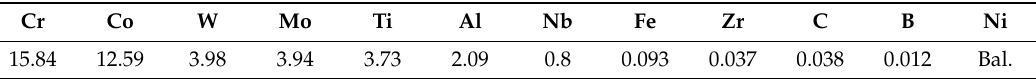
Table 1. The chemical composition of the superalloy (mass fraction,